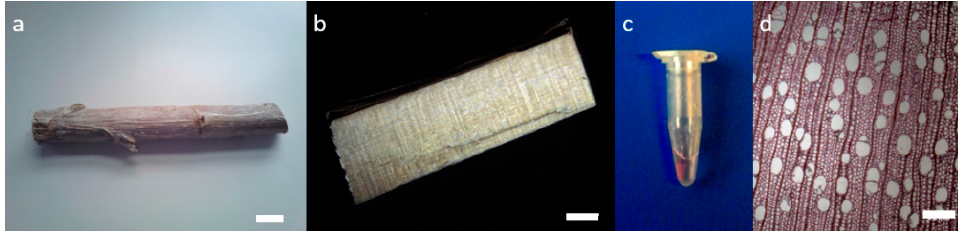
Figure 5. Preparation steps for the poplar sample thin sections: ( a ) Raw poplar wood (scale bar: 2 cm); ( b ) poplar fragment (scale bar: 2 mm); ( c ) poplar section with a thickness of 60 µm incubated with the PEG-R fluorescent probe in a plastic tube; ( d ) poplar section observed in photon microscopy (scale bar: 0.2 mm).